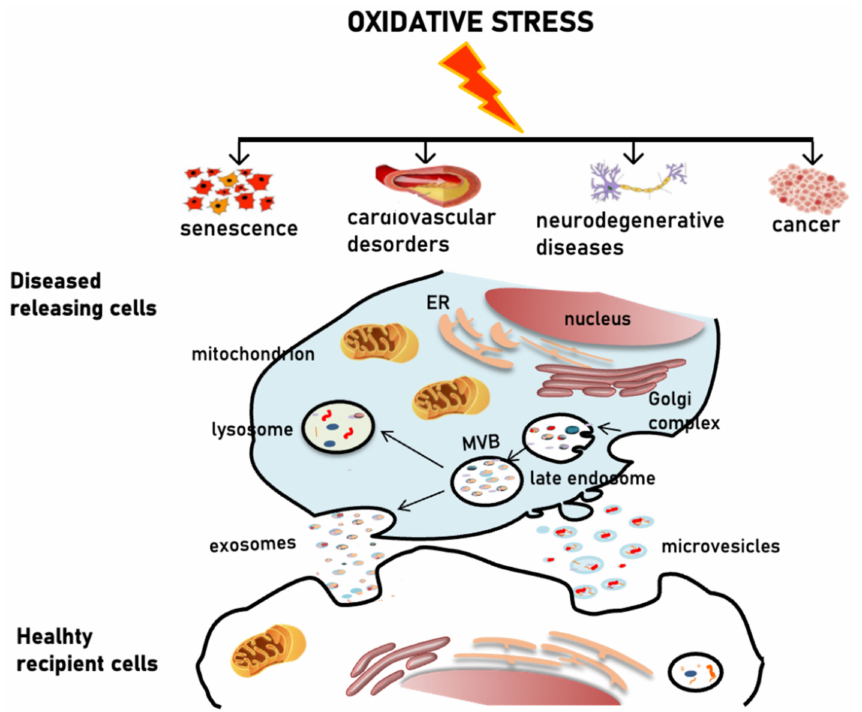
Figure 3. Schematic representation of the EV-mediated pathophysiology of oxidative stress-related diseases. Oxidative stress is associated with the pathogenesis of several disorders. Pro-oxidant conditions induce the release of EVs. Diseased cells can eliminate ROS and oxidized toxic molecules via EVs, thus spreading pathological alterations by delivering their cargo to healthy